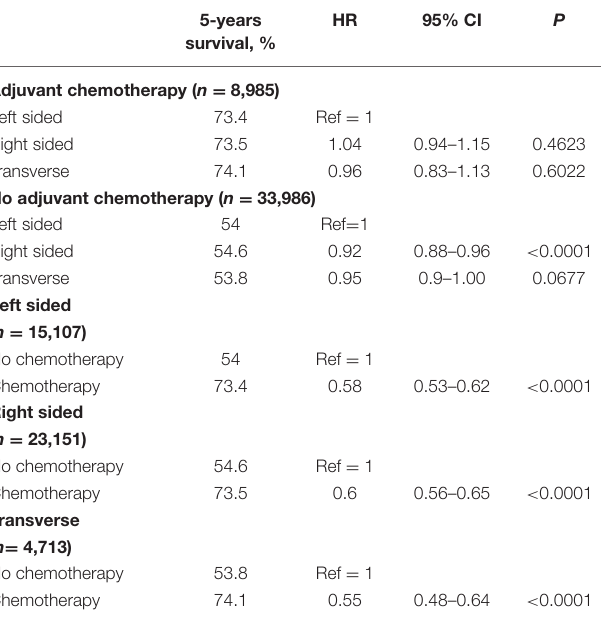
TABLE 5 | Multivariate subgroup analysis of 5-years OS, according to adjuvant chemotherapy and tumor